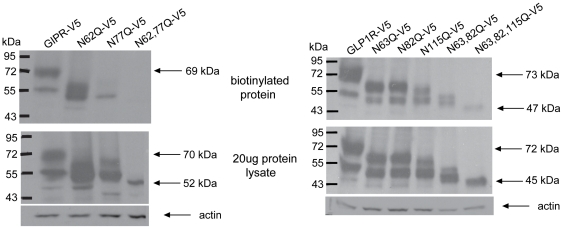
N-glycosylation increases the presence of cell surface isoforms of GIPR and GLP-1R protein.Western Blots of biotinylated cell surface protein (upper) and total protein lysate (middle) for V5-tagged GIPR (left) and GLP-1R (right). Upper and middle blots were probed with a mouse monoclonal antibody to the V5 epitope while the lower blots were probed with a rabbit polyclonal antibody to actin as a loading control. Note the absence of biotinylated protein in the lane containing N62,77Q-GIPR but not in the lane containing N63,82,115Q-GLP-1R.